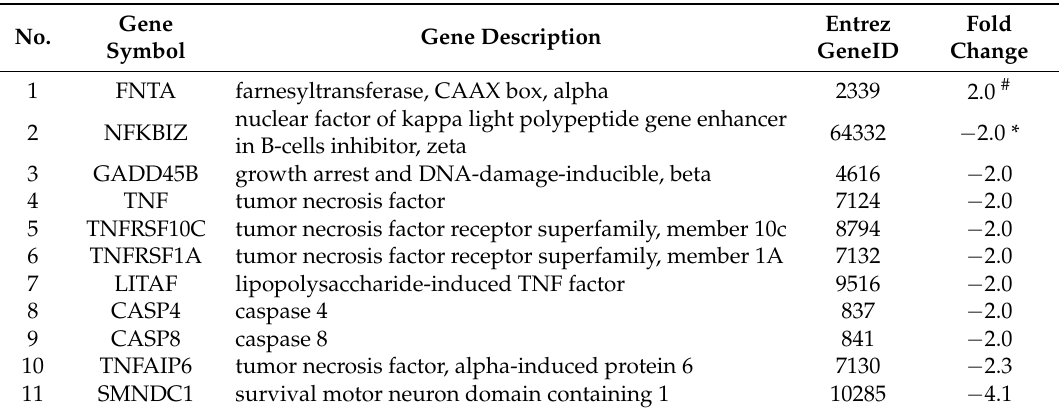
Table 5. The list of pro-apoptotic genes with the largest change of expression (at least 2 folds) in CD34+ cells from untreated GHD patients prior to GH-TS compared to their controls.